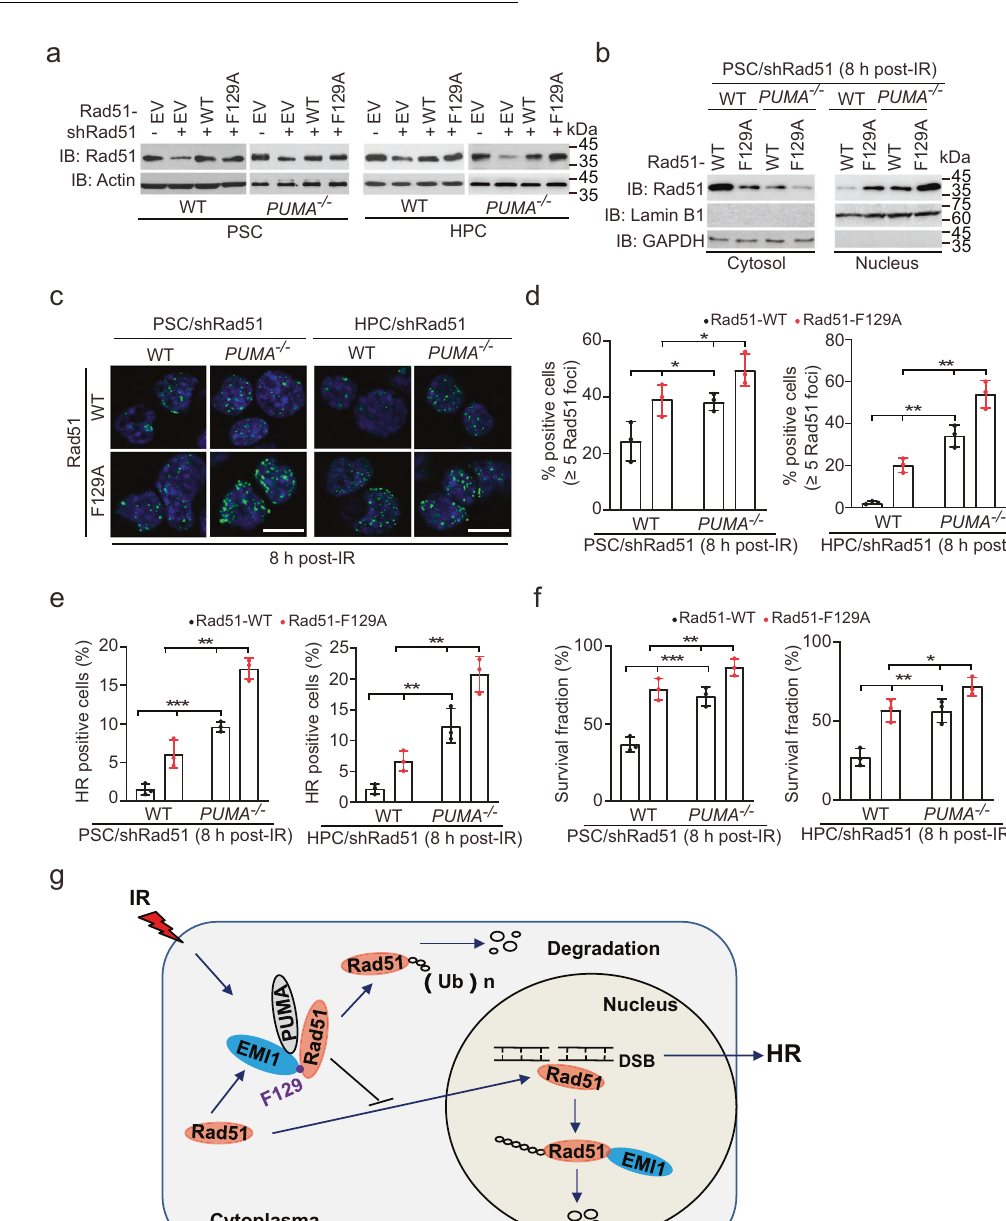
Fig. 6 Knockout of PUMA promotes IR-induced cytoplasm-to-nucleus translocation and focus formation of Rad51, HR repair, and cell survival. a IB of re-expression of shRNA-resistant Rad51 WT or the F129A mutant in PUMA WT and KO PSC/shRad51 and HPC/shRad51 cells. b Protein expression levels of Rad51 WT and F129A mutant in the cytosol and the nucleus in PSC/shRad51 cells after IR. Lamin B1 and GAPDH are the markers for nuclear and cytosolic fraction. c Representative images of effects of re-expression of the F129A mutant on Rad51 focus formation in PUMA WT and KO PSC/shRad51 or HPC/shRad51 cells after IR. DAPI was used to show nucleus. Scale bars, 10 μ m. d Quanti fi cation of positive cells with Rad51 foci in c . e Effects of re-expression of the F129A mutant on HR repair. f Effects of re-expression of the F129A mutant on cell survival after IR. Cell survival analysis was performed according to the MTT assay method with a Cell Titer 96 Aqueous Cell Proliferation Assay kit. g A working model. IR-induced PUMA interacts with cytoplasmic Rad51 and EMI1, which facilitates EMI1-mediated Rad51 ubiquitination and degradation, thereby leading to the inhibition of Rad51-mediated promoted DNA repair and enhancement of IR-induced cell death. Data are representative of three independent experiments with similar results. Error bars, SD. * P < 0.05, ** P < 0.01 Rad51 focus formation and HR repair, compared to Rad51 WT, re- mutant increased Rad51 focus formation in PUMA WT PSCs and expression of the F129A mutant increased cell radioresistance in HPCs after IR (Fig. 6c, d). Re-expression of the F129A mutant in PSC/shRad51 and HPC/shRad51 cells (Fig. 6f). In addition, PUMA PUMA KO PSCs and HPCs further enhanced Rad51 focus formation KO in combination with re-expression of the F129A mutant further (Fig. 6c, d). Then, we performed HR repair analysis and revealed enhanced stem cell radioresistance (Fig. 6f), suggesting that that compared to Rad51 WT, re-expression of the F129A mutant targeting the PUMA-EMI1-Rad51 axis has the potential to confer a markedly promoted HR repair in PUMA WT and KO PSCs and HPCs survival advantage to stem cells. Taken together, our data (Fig. 6e). Moreover, the enhancement of HR repair was the highest demonstrate that IR-induced PUMA interacts to both cytosolic in PUMA KO cells (Fig. 6e). Consistent with PUMA KO-enhanced